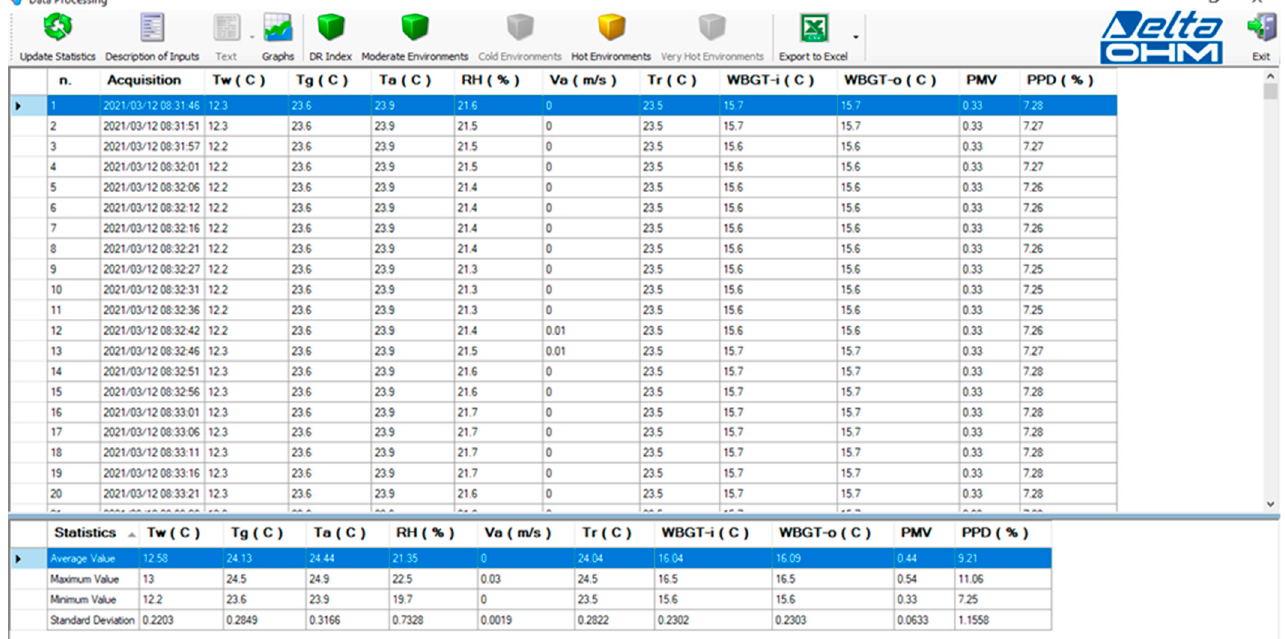
Figure A2. Screen capture of DeltaLog 10 software showing the data acquisition performed during the practical works of Group D.